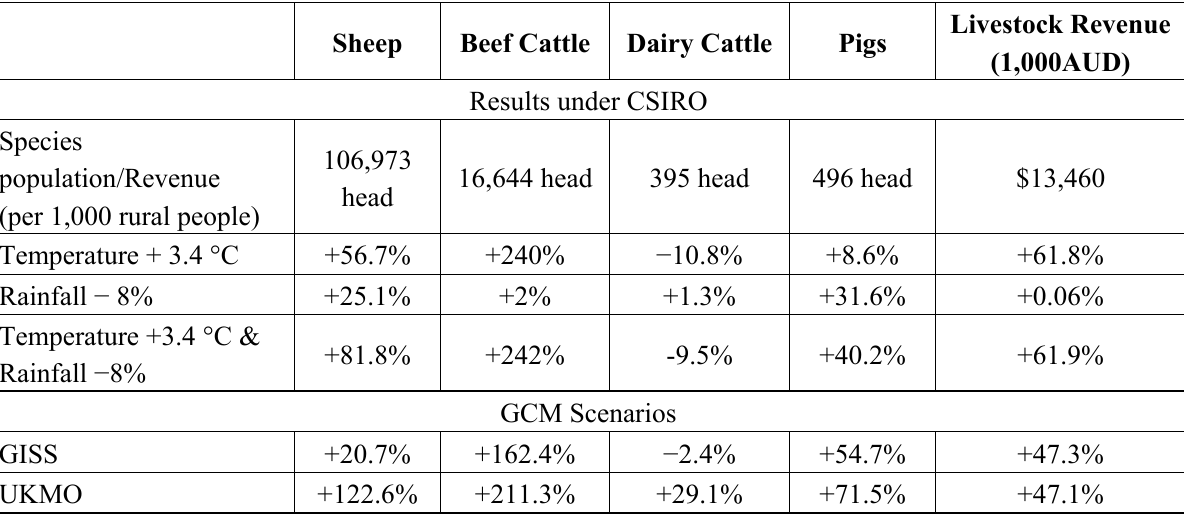
Table 11. The impacts of climate scenarios by